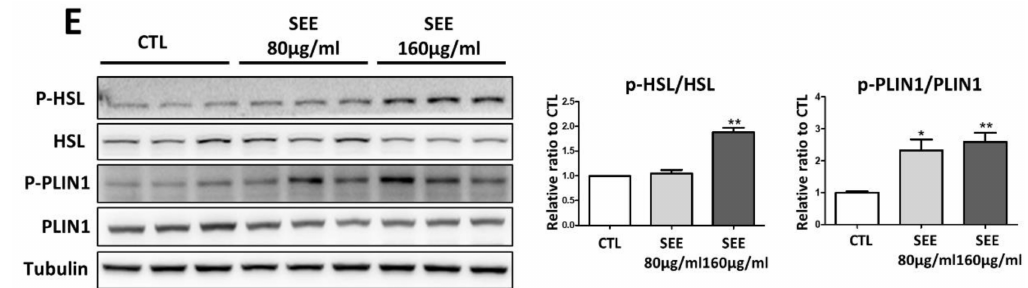
Figure 1. E ff ects of in-vitro soybean embryo extract treatment on lipid content in adipocytes di ff erentiated from C3H10T1 / 2 cells. ( A ) Representative images of boron dipyrromethene fluorophore (BODIPY) staining of adipocytes di ff erentiated from C3H10T1 / 2 cells, treated with soybean embryo extract(SEE)(80 µ g / mL,160 µ g / mL)for24h, alongwithbrightfiledimages; ( B )quantificationofBODIPY staining intensity of A. Groups of 160 µ g / mL SEE treated have the lowest BODIPY intensity ( n = 6, means ± SEM, * p < 0.05, ** p < 0.01, *** p < 0.001); ( C ) intracellular triglyceride (TG); ( D ) glycerol levels in conditioned media ( n = 6, means ± SEM, * p < 0.05, ** p < 0.01, *** p < 0.001); ( E ) immunoblot analysis of phosphorylated hormone-sensitive lipase(p-HSL), hormone-sensitive lipase(HSL), phosphorylated perilipin1(p-PLIN1), perilipin1(PLIN1) and tubulin in adipocytes di ff erentiated from C3H10T1 / 2 cells treated with vehicle (CTL), SEE (80 µ g / mL) and SEE (160 µ g / mL) for 24 h. ( n = 6, means ± SEM, ** p < 0.01).